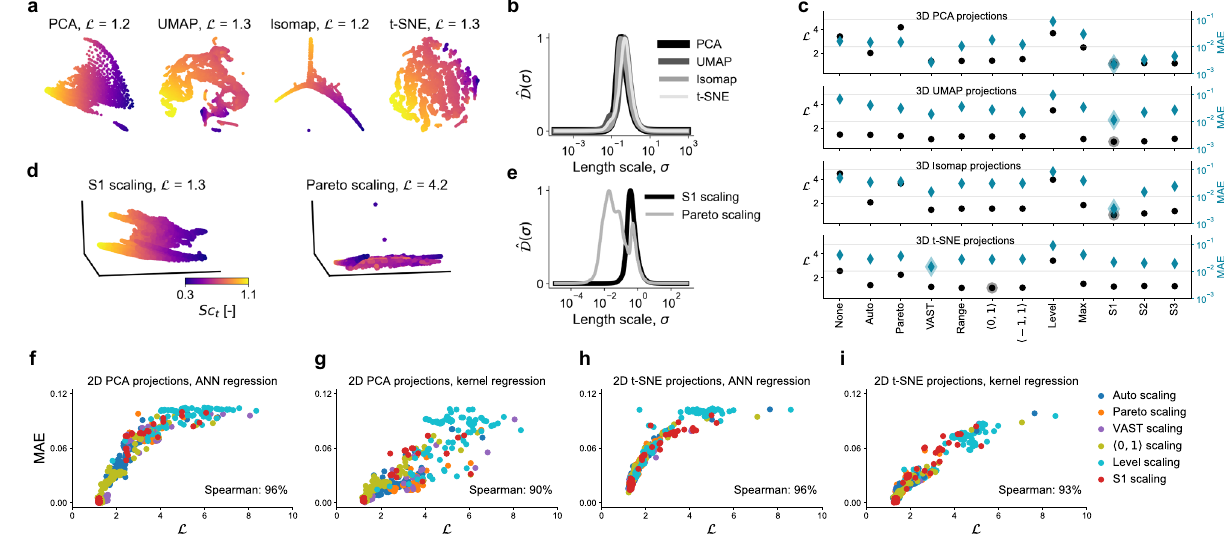
Figure 7. Relating the cost function to nonlinear regression predictions based on various low-dimensional projections of the atmospheric pollutant dispersion data. The relevant dependent variable is the turbulent Schmidt number, φ = Sc t . ( a ) 2D data projections using PCA, UMAP, Isomap and t-SNE with the cost for φ = Sc t reported for each projection. ( b ) The ˆ D (σ) curves corresponding to the 2D projections. ( c ) Ranking of different data scaling techniques using the cost function (black dots) with the mean absolute errors (MAE) for ANN prediction of Sc t across all four projection techniques (blue diamonds) using 3D data projections. The minimum L and the minimum MAE for each technique is marked with a shaded outline. Scalings that generally exhibit lowest costs (VAST, S1, S2, S3) also result in the smallest MAE. ( d ) Example 3D PCA projections resulting from applying two scaling options to the original data: S1 and Pareto scaling. For this dataset, S1 scaling allowed for generating a manifold where the dependent variable of interest, Sc t , has a smooth gradient across one of the manifold dimensions. Pareto scaling, exhibiting high cost, collapses most of the data observations onto a planar structure. ( e ) The ˆ D (σ) curves corresponding to the 3D PCA projections with S1 and Pareto scaling. ( f – i ) Scatter plots of L versus MAE from ANN and kernel regression predictions of Sc t . We show predictions based on 600 different 2D PCA projections ( f , g ), and based on 600 different 2D t-SNE projections ( h , i ) as the independent manifold parameters. We test a few selected scaling techniques applied to the atmospheric dispersion data; legend applies to all figures ( f – i